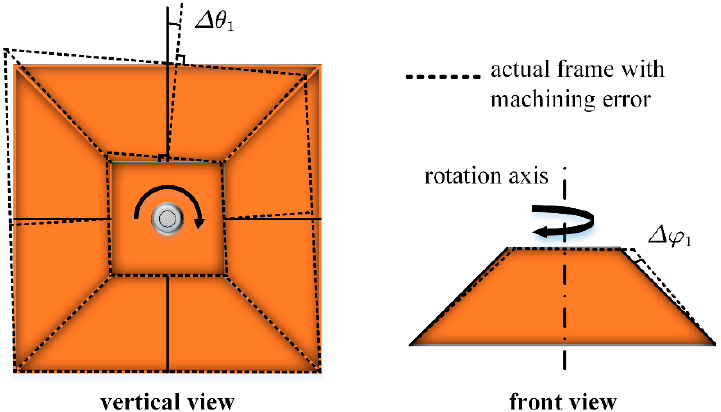
Figure 10. Surface angle deviation of quadrangular tower mirror.